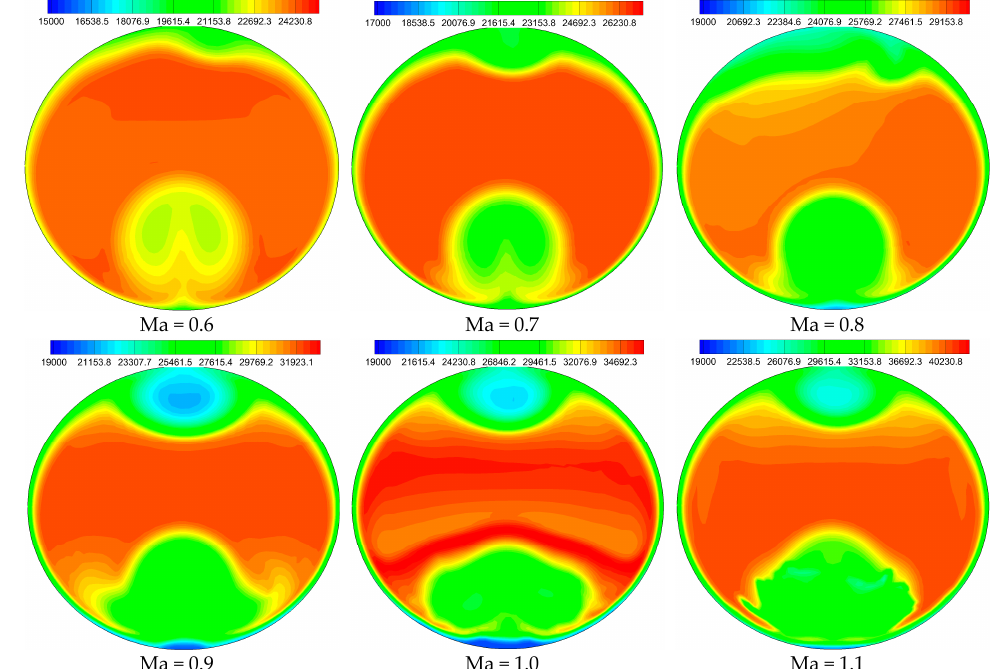
Figure 18. Total pressure of outlet at off-design conditions.